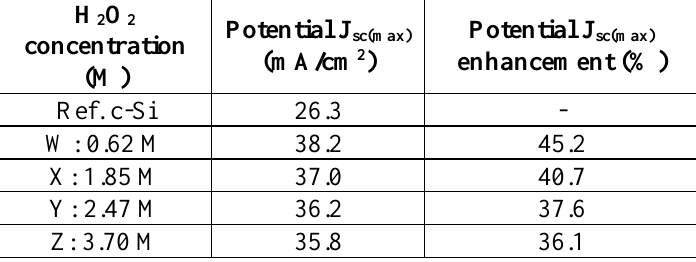
Table 2: Calculated potential J and J enhancement of b-Si wafers fabricated with sc(max) sc(max) different H O concentrations (W: 0.62 M, X: 1.85 M, Y: 2.47 M and Z: 3.7 M). 2 2